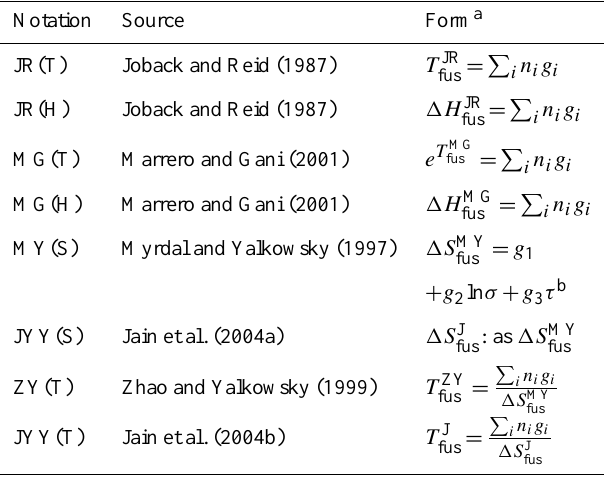
a g i represent parameter values, n i the frequency of group i . b σ is the rotational symmetry number (Dannenfelser and Yalkowsky, 1996) and τ the effective torsional bond number (Myrdal et al., 1996).